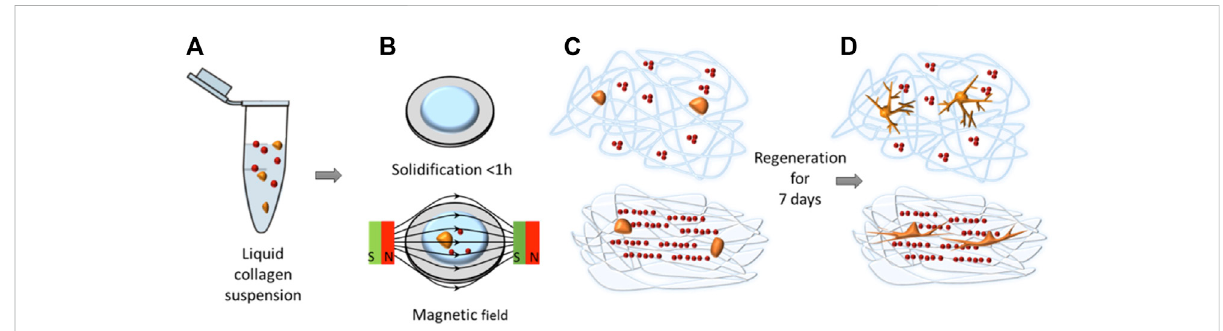
FIGURE 7 Schematic illustrations of magnetic hydrogels with alignment structure for guiding neuronal regeneration. (A) Collagen precursor solution containing neurons (orange) and magnetic nanoparticles (red). (B) Solidi fi cation of the solution with/without a magnetic fi eld. (C) Magnetic fi eld can induce the linear alignment of magnetic nanoparticles and collagen fi bers. (D) Magnetic nanoparticle chains and fi bers can guide the growth of neurons as topographical cues. (Reproduced with permission from (Antman-Passig and She fi , 2016) Copyright 2016 American Chemical